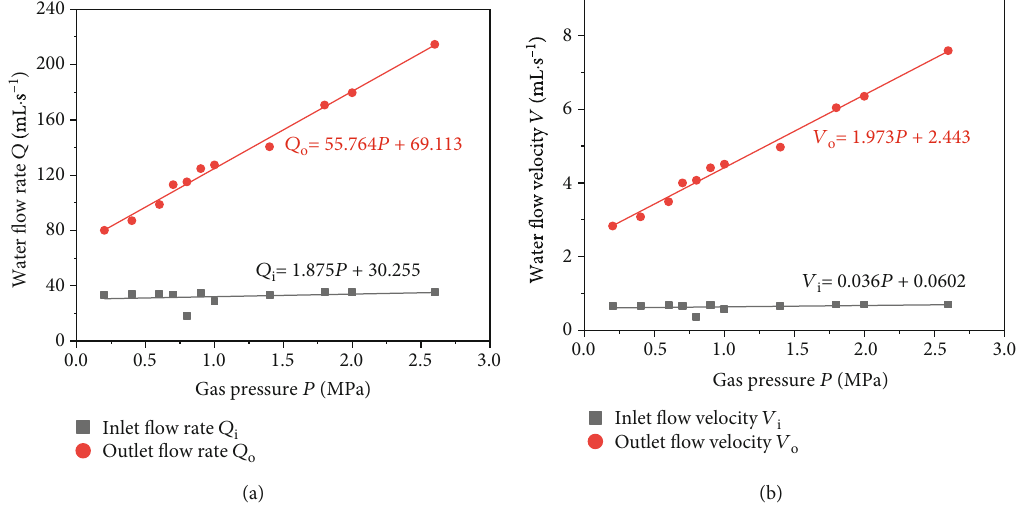
Figure 5: Inlet and outlet (a) fl ow rate and (b) fl ow velocity for the pressure measuring device at di ff erent gas